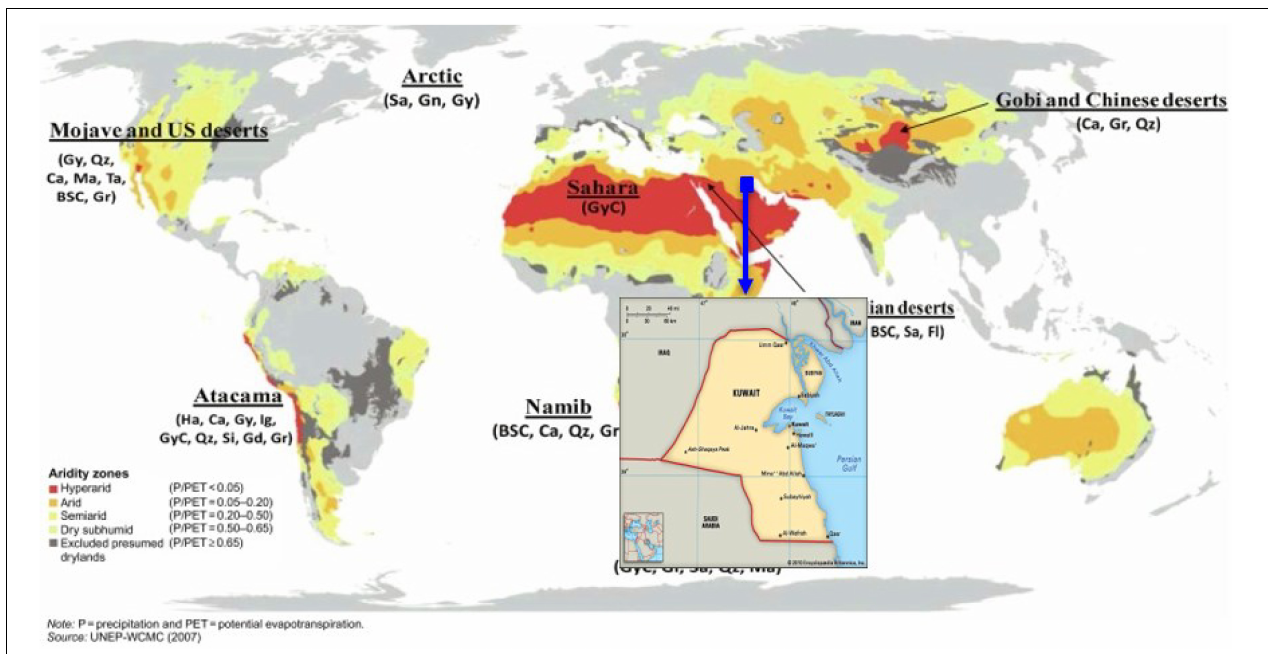
FIGURE 1 | Global arid and desert weather conditions (Meslier and DiRuggiero, 2019).